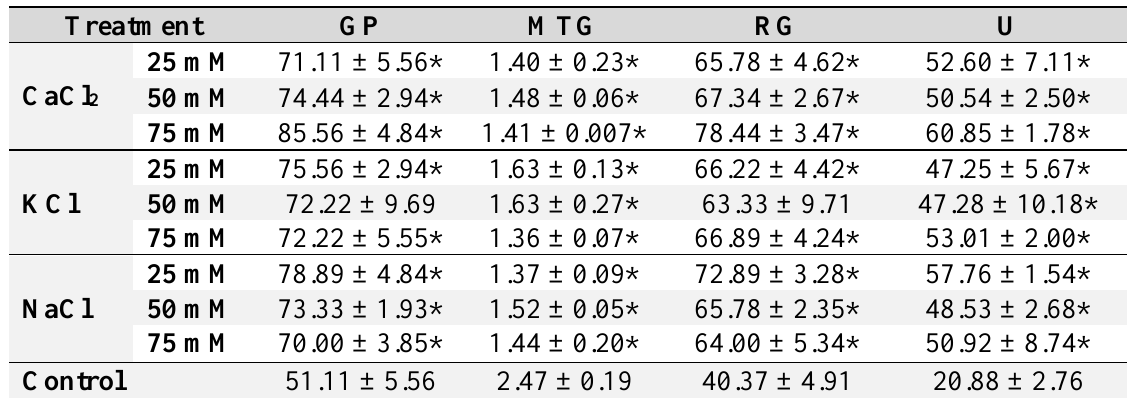
Table 2. Effect of halopriming on germination characteristics of Raphanus sativus L . : GP − germination percentage; MTG − mean time of germination; RG − rate of